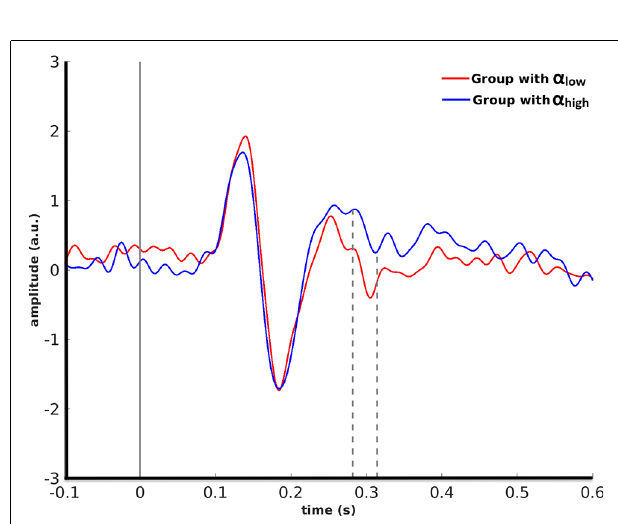
FIGURE 4 | Grand average over the participants’ evoked responses to monkey faces in the right FFA for the α low vs. the α high conditions are partitioned based on pre-stimulus alpha power in the right